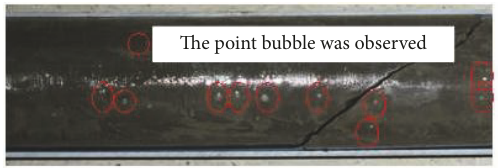
Figure 11: The core sample on which bubbles were